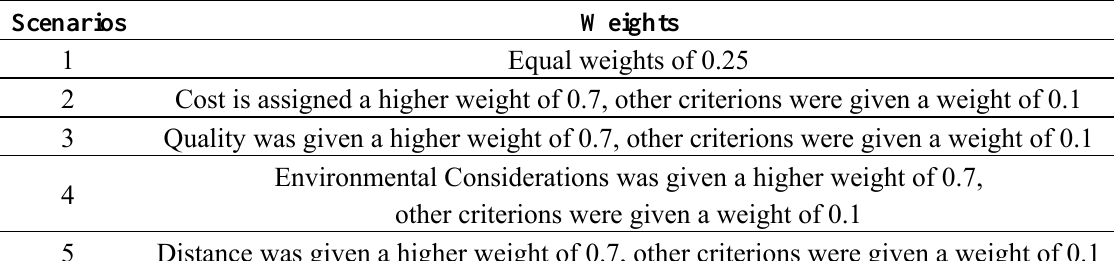
Table 4. Weights assigned to each